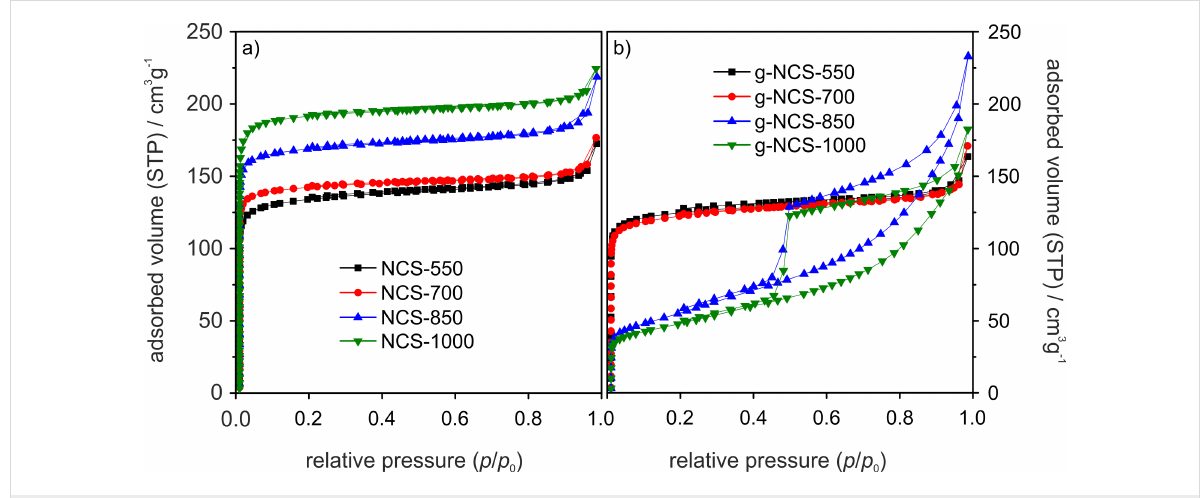
Figure 7: N 2 sorption isotherms of the (a) NCS and (b) g-NCS catalyst series.